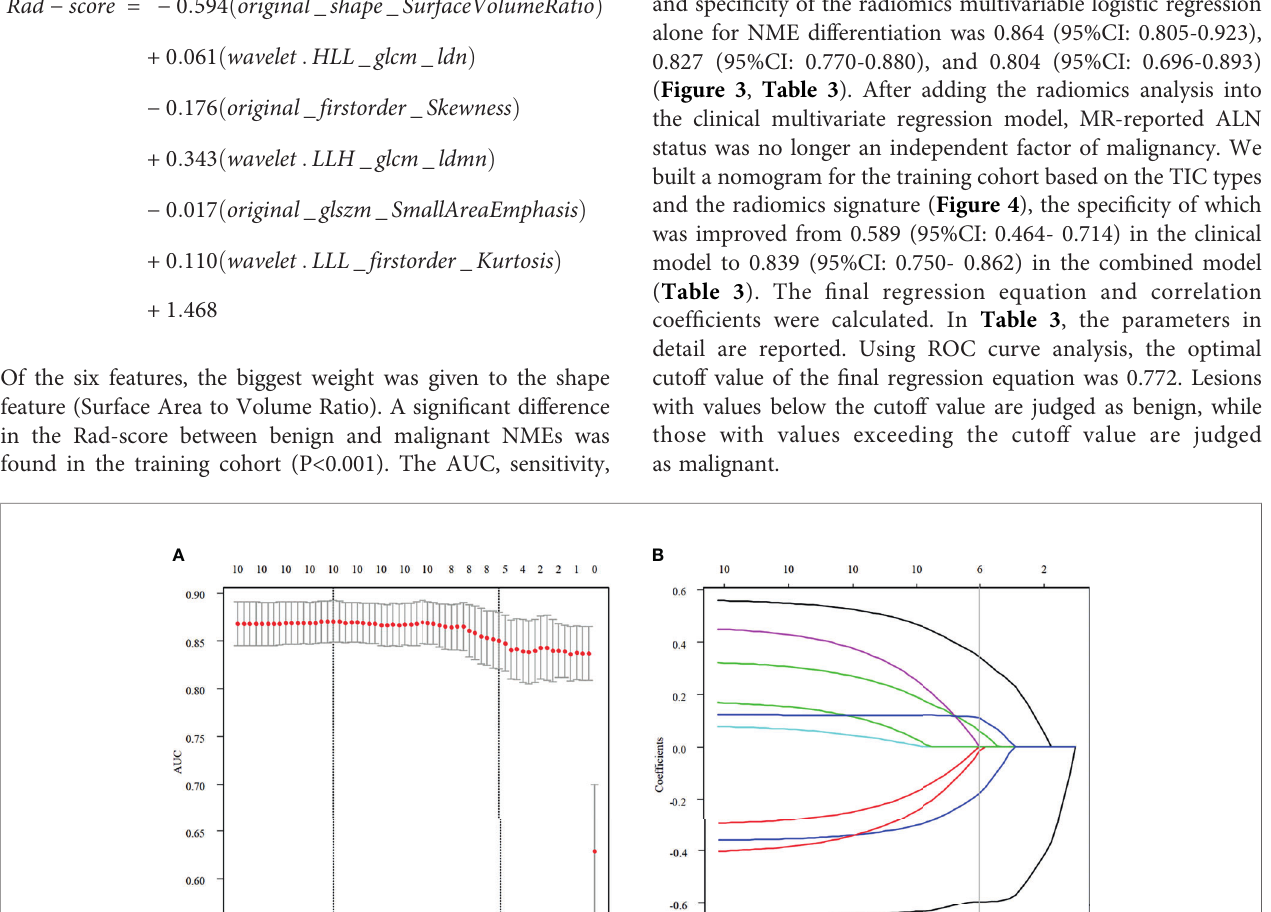
( Figure 3 , Table 3 ). After adding the radiomics analysis into the clinical multivariate regression model, MR-reported ALN status was no longer an independent factor of malignancy. We built a nomogram for the training cohort based on the TIC types and the radiomics signature ( Figure 4 ), the speci fi city of which